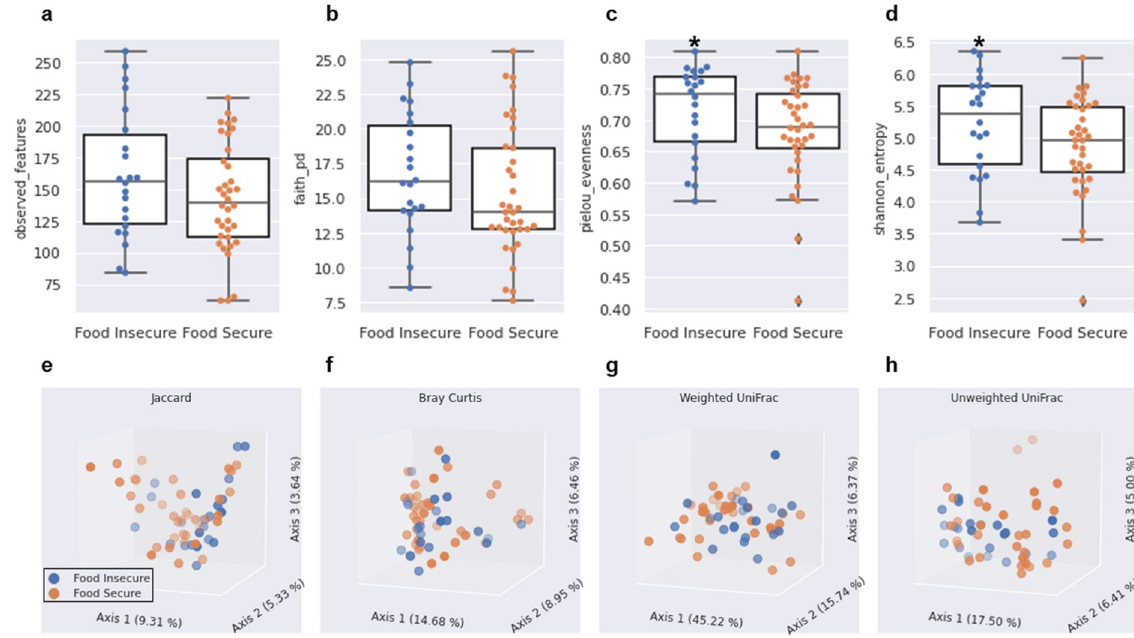
Figure 2. Alpha diversity boxplots showing; ( a ) Observed features, ( b ) Faith’s PD, ( c ) Pielou’s E, and ( d ) Shannon index, by food security status. Boxes denote the interquartile range (IQR) between the first and third quartiles, and the horizontal line defines the median. Whiskers represent the smallest (y-min) and largest (y-max) observations within 1.5 times the IQR from the first and third quartiles. Asterisk denotes significance at p < 0.05. Principal coordinates’ analysis for beta diversity metrics; ( e ) Jaccard, ( f ) Bray Curtis, ( g ) Weighted UniFrac, and ( h ) Unweighted UniFrac distances by food security